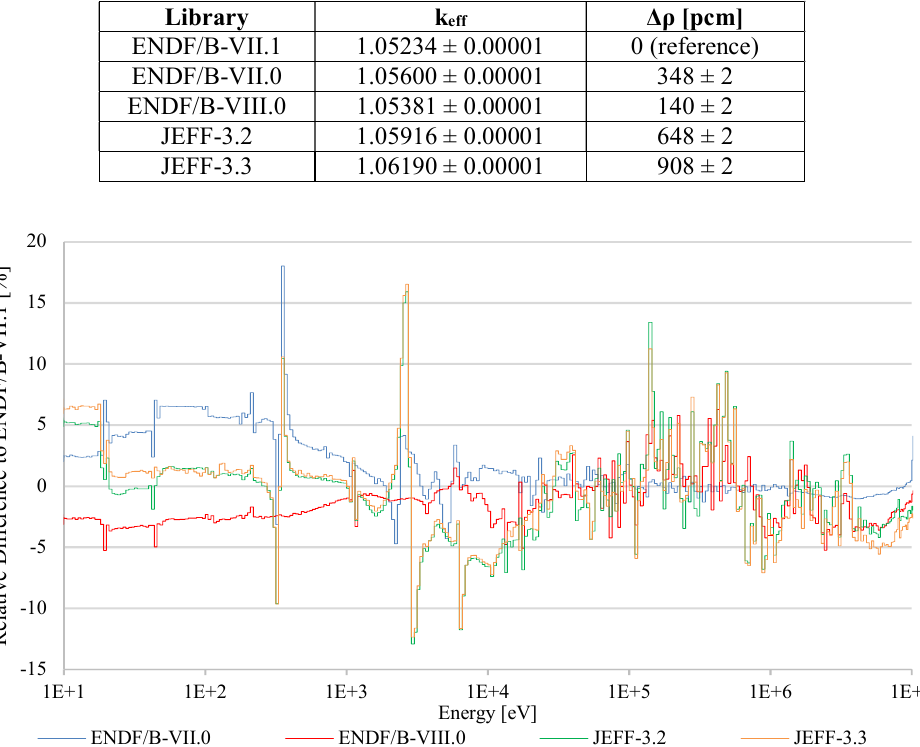
Figure 2. Relative Group-Wise Flux Differences over Active Core Region.